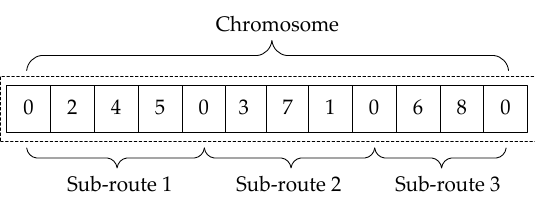
Figure 4. The representation of the problem.